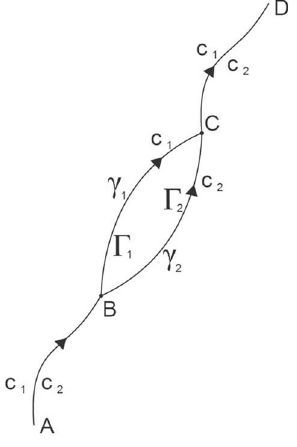
Fig. 1 Synchronized clocks c 1 and c 2 follow world lines γ 1 and γ 2 , which are coincident from point A to B , where they are separated to follow the parts (cid:4) 1 and (cid:4) 2 of these lines until point C , where they are once again joined and continue together until point